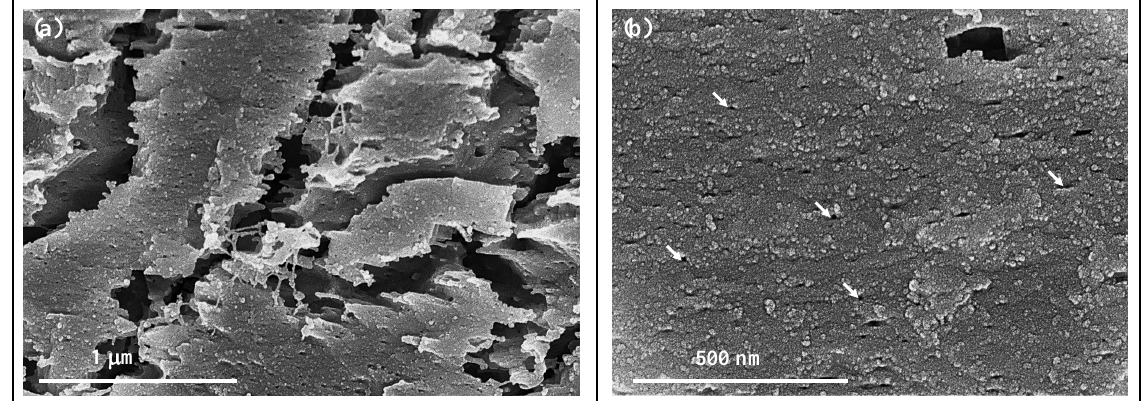
Figure A7. Hydrothermally altered Arctica islandica shell portions. Burial fluid was used for alteration at 100 ◦ C and for 28 days. (a) As the organic membranes and fibrils are destroyed by alteration, large gaps appear between and numerous minute holes within the mineral units. (b) The biological aragonite of Arctica islandica retains its nanoparticulate appearance after alteration conducted for 28 days at 100 ◦ C.